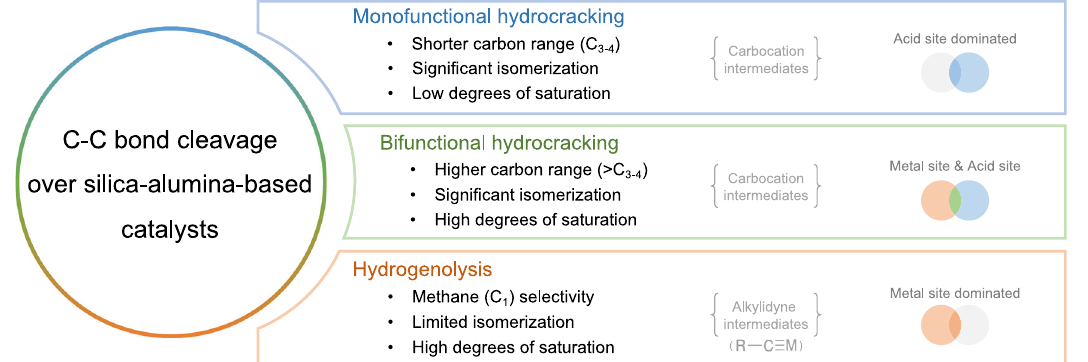
Fig. 1 | Schematic summary of the product distributions for different C – C bond cleavage mechanisms.